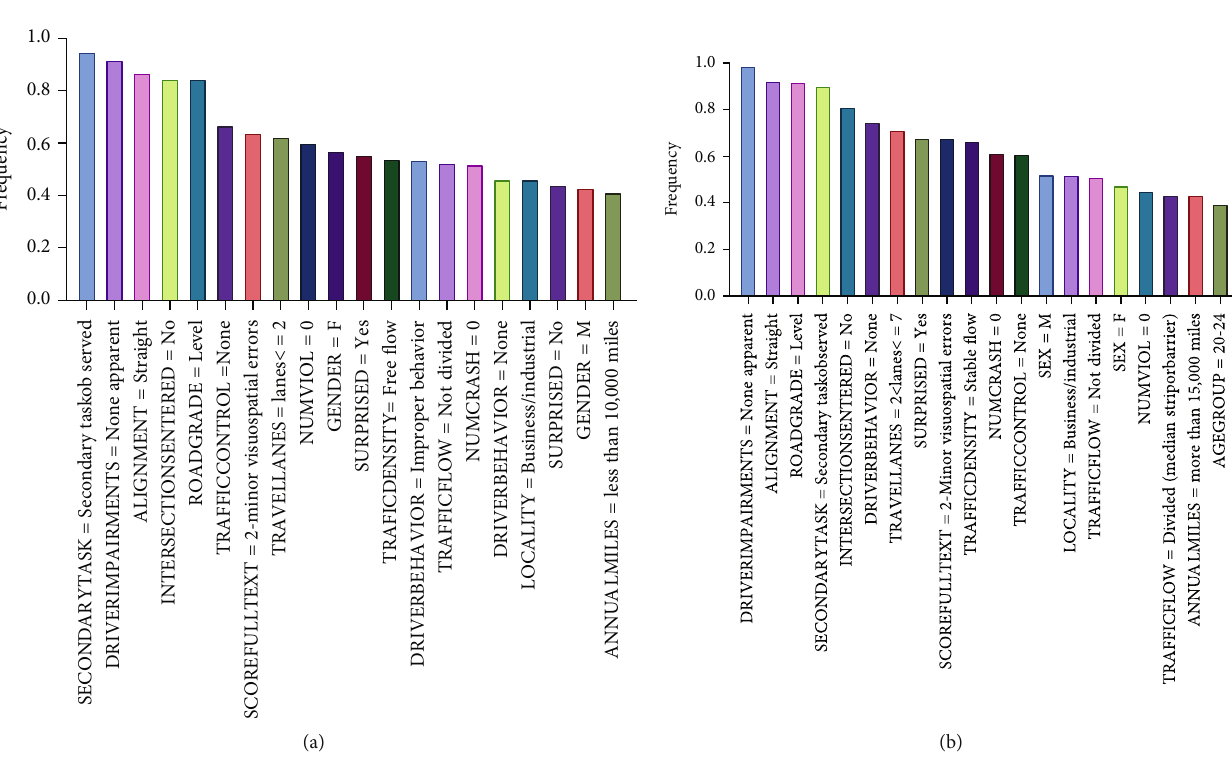
Figure 4: Item frequency in (a) crash events and (b) near-crash